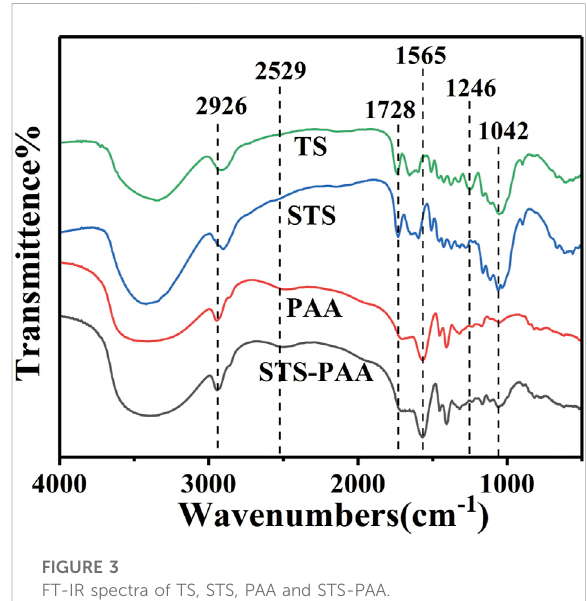
FIGURE 3 FT-IR spectra of TS, STS, PAA and STS-PAA.